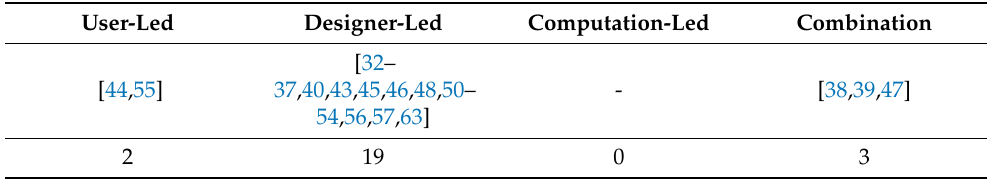
Table 3. Design approach used for text entry methods for VIBPs. The number of papers per approach is reported in the final row of the